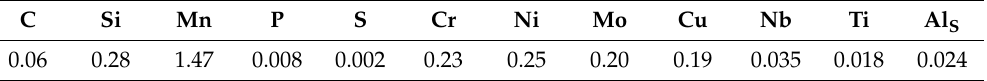
Table 1. Chemical compositions of experimental steel (wt. %).